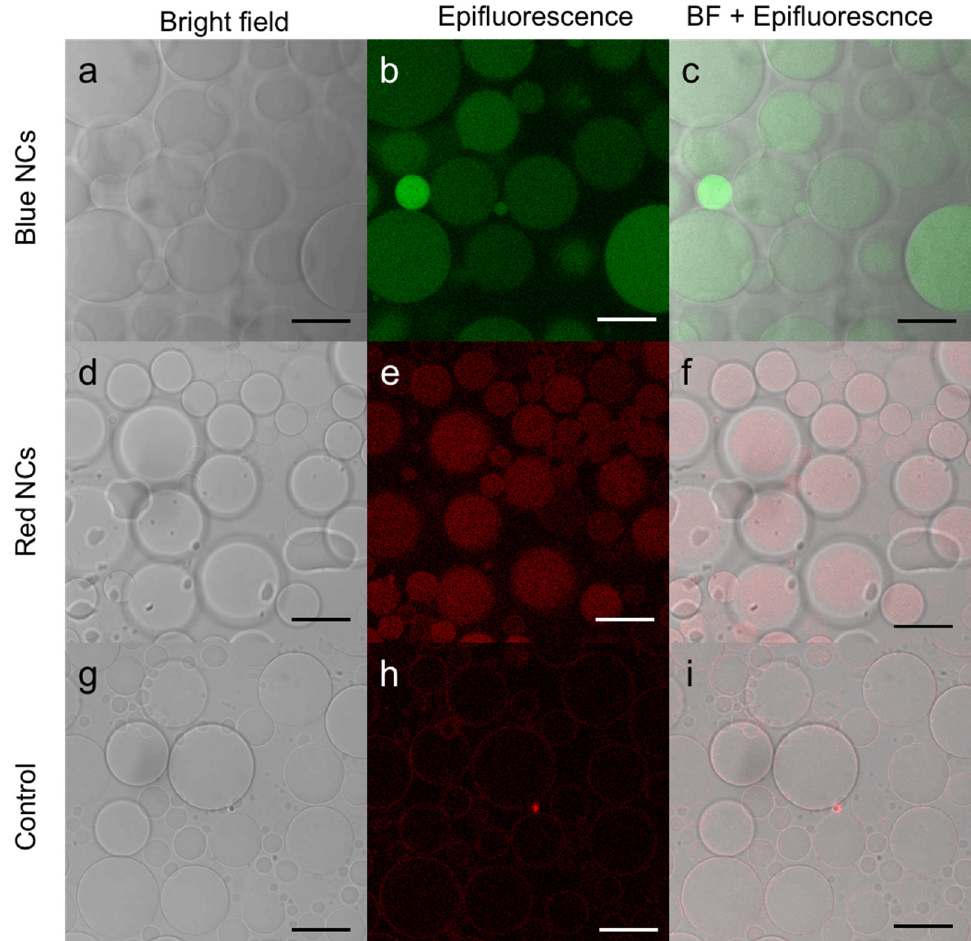
Figure 3. Confocal microscopy image of ( a – c ) C 3 E 6 D Blue Au NCs, ( d – f ) C 3 E 6 D Red Au NCs’ encapsulated in DOPC GUVs, and ( g – i ) DOPC GUVs without Au NCs as a control obtained by ( a,d,g ) bright field, ( b,e,h ) luminescence, and ( c,f,i ) merged images. Scale bar, 20 μ M.